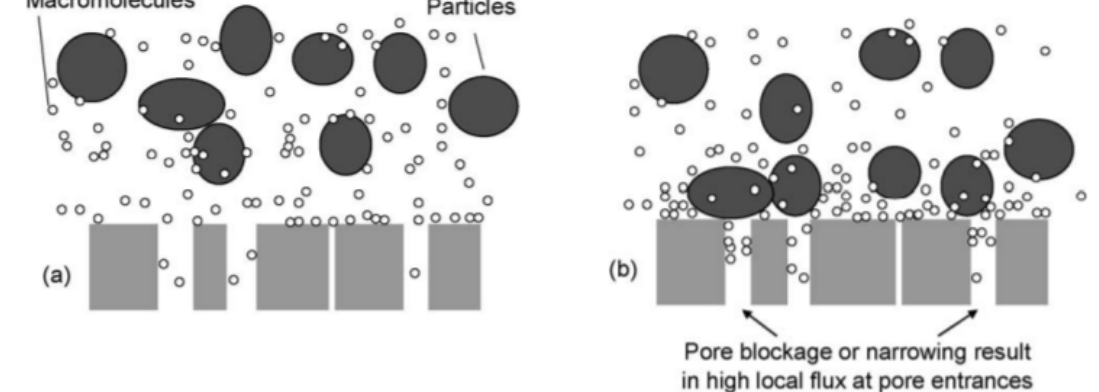
Figure 6. Progressive pore blockage leading to rapid TMP increase. ( a ) The initial low fouling phase and ( b ) enhanced rejection of macromolecules and deposition of larger particles by the pore closure (reprinted with permission from [66], Copyright 2006, Elsevier).